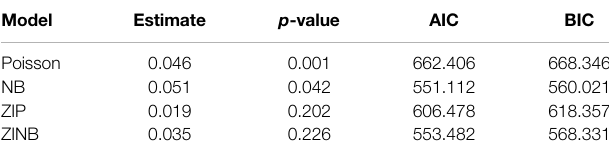
TABLE 2 | The regression parameter estimates, p -values, values of AIC and BIC from the Poisson, NB, ZIP, and ZINB models. Model Estimate